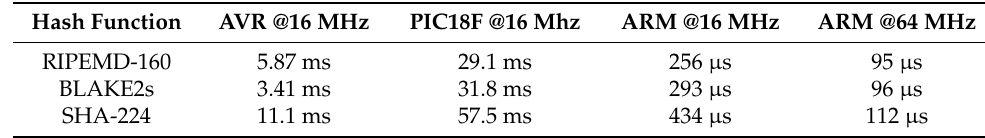
Table 3. Processing Times for the Considered Hash Functions (less is better).